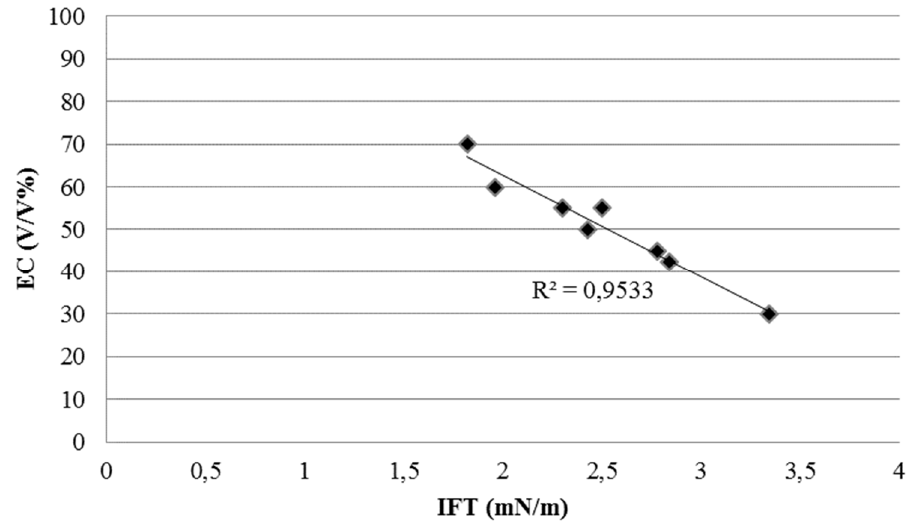
Figure 2. Emulsification capacity vs. IFT for surfactant mixtures from non-ionic surfactants with the same structures.